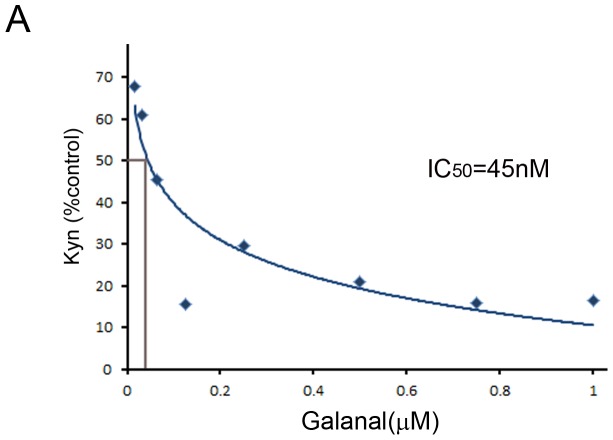
Inhibition of cellular IDO1 activity by galanal.LPS-stimulated THP-1 cells were exposed to various concentrations of galanal. Percentage inhibition in LPS-stimulated THP-1 cells against control cells was plotted and IC50 value determined.